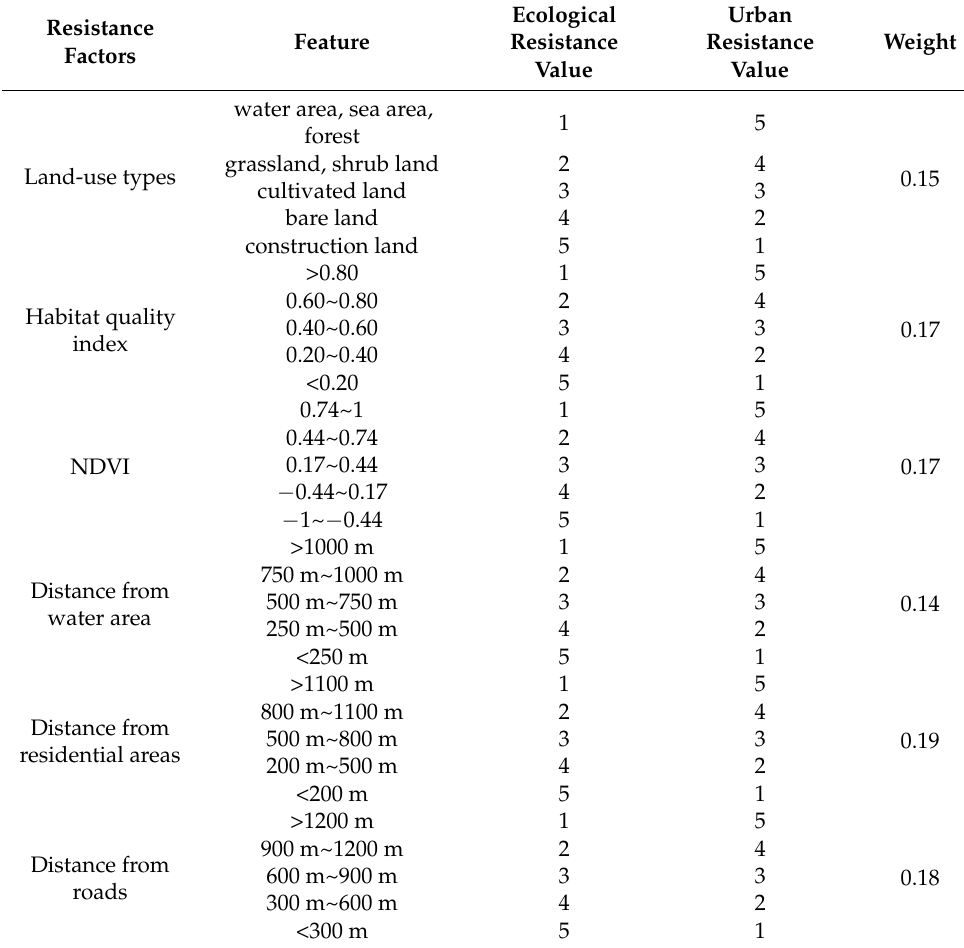
Table 3. Resistance factor evaluation